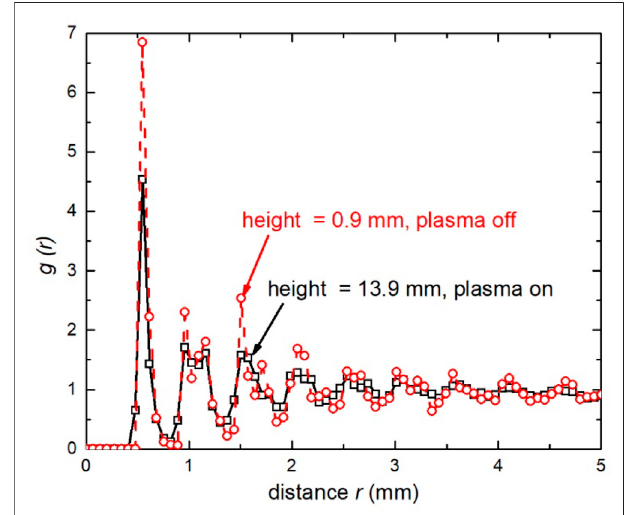
FIGURE 7 | Pair correlation function g ( r ), which indicates the probability of fi nding two particles at given separation r . These experimental data were obtained from top-view camera images: Figure 4A with plasma on and steadily levitated microspheres, as compared to Figure 5A with plasma off and falling microspheres. The close resemblance of these two curves is further con fi rmation that the microscopic structure of the cloud of microspheres did not change signi fi cantly, as it fell to the lower